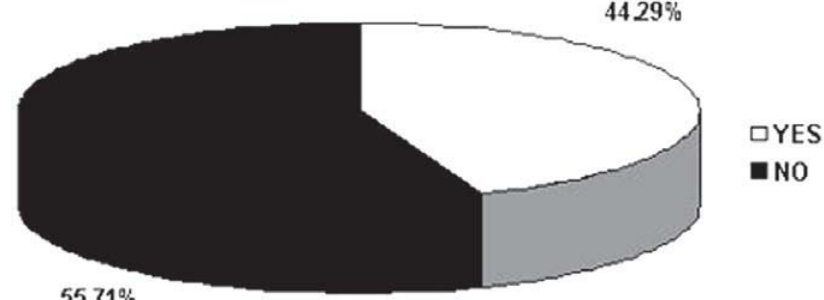
FIGURE 1- Percent distribution of dentists according to breach of professional confidentiality to friends or spouses. Andradina/ SP, 2006